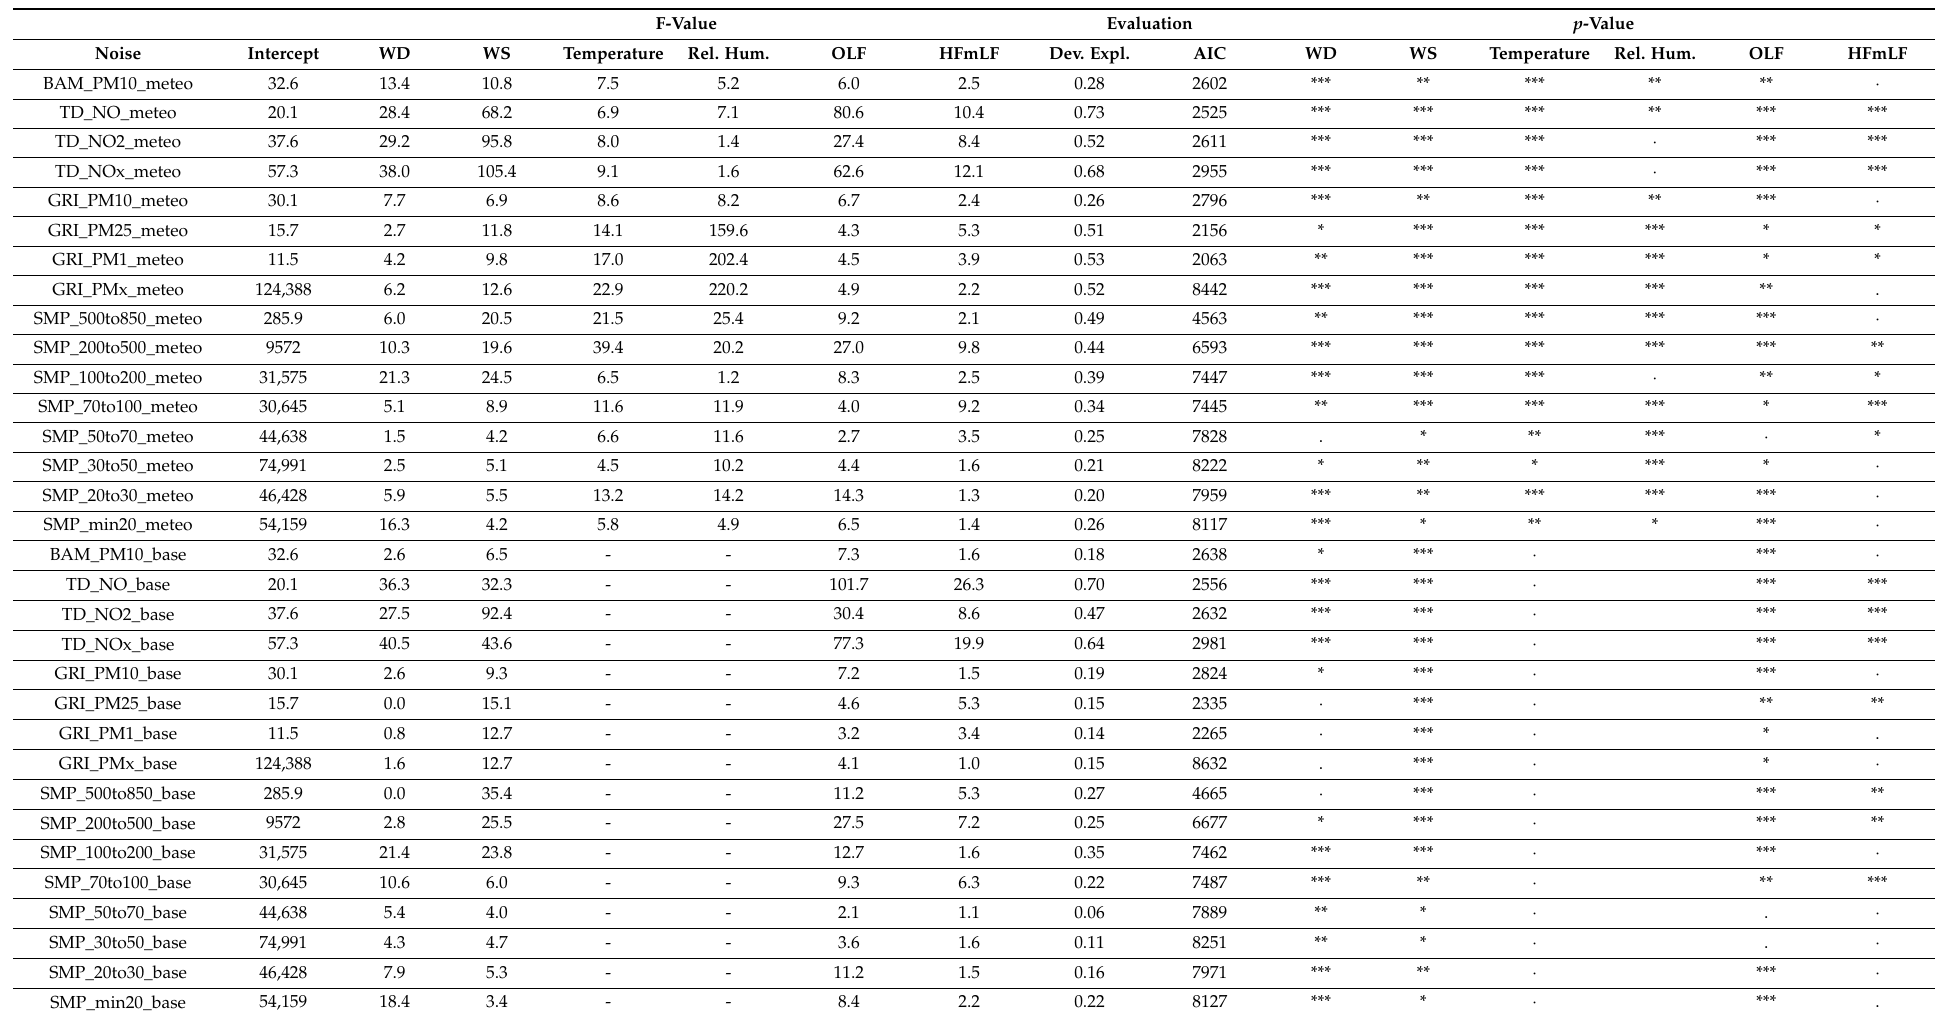
Table 3. Summary of the GAM models for the noise parameters: OLF and HFmLF, with and without temperature and relative humidity. F-Value